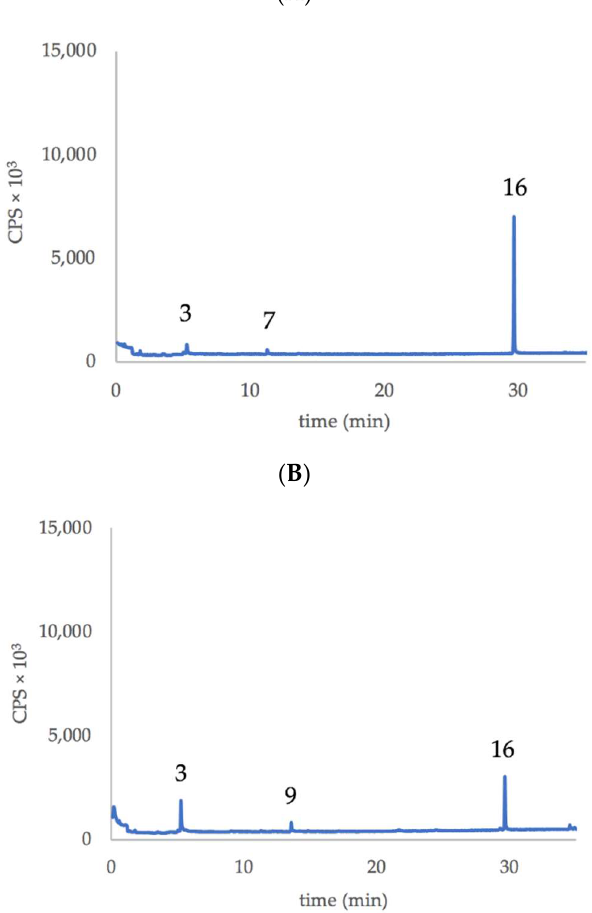
Figure 2. Representative chromatograms showing the main VOCs emitted by the flowers T. violacea . ( A ) purple flowers of var. ‘Violacea’, ( B ) white flowers of var. ‘Alba’. Numbers indicate the compounds listed in Table 1. Table 1. Main VOCs emitted by T. violacea flowers var. ‘Violacea’ and ‘Alba’, purple and white flowers, respectively. Numbering of volatile compounds respects the order of elution considering the set of compounds identified after the analysis of flowers and of the whole plants (see Table 2) so as to keep the numbering univocal. The values given are the averages of three repetitions; standard-error values are not reported but were all values within